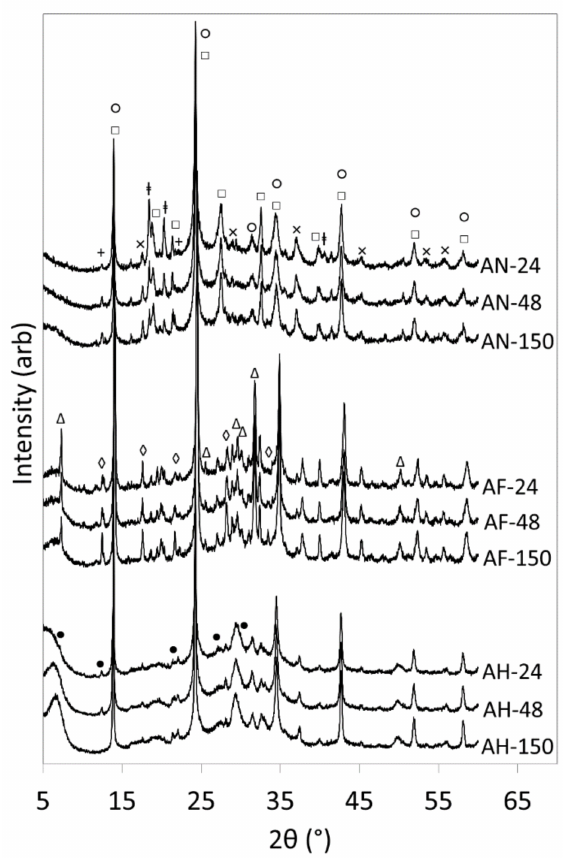
Figure 1. XRD patterns of hydrothermal products of amber container glass and aluminium nitrate (AN), aluminium foil (AF) and amorphous aluminium hydroxide waste (AH) synthesised for 24, 48 and 150 h in 4.5 M NaOH (aq) at 100 ◦ C. Key: sodalite; (cid:3) cancrinite; ∆ tobermorite; ♦ zeolite Na-P1; (cid:35) + zeolite P2; • zeolite A; × katoite; } aluminium hydroxide. Table 2. Compositions of the hydrothermal reaction products of amber container glass and alu- minium nitrate.